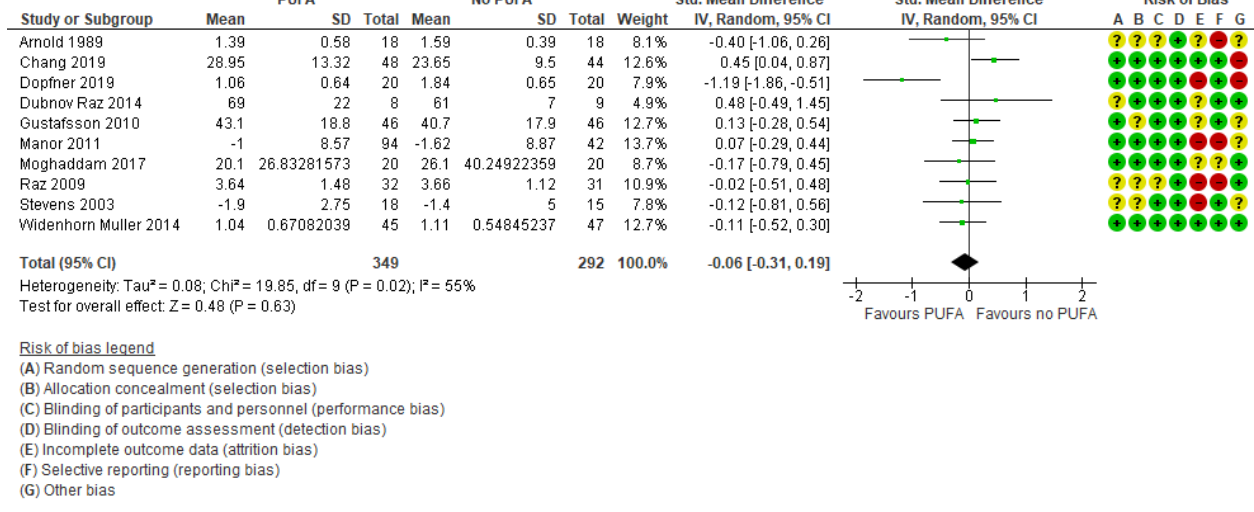
Figure 4. Forest plot of comparison: polyunsaturated fatty acids (PUFA) vs. placebo, outcome: teacher-reported core symptoms (end of treatment). Green square indicates summary estimates of the individual studies. Black diamond indicates total summary effect estimate.